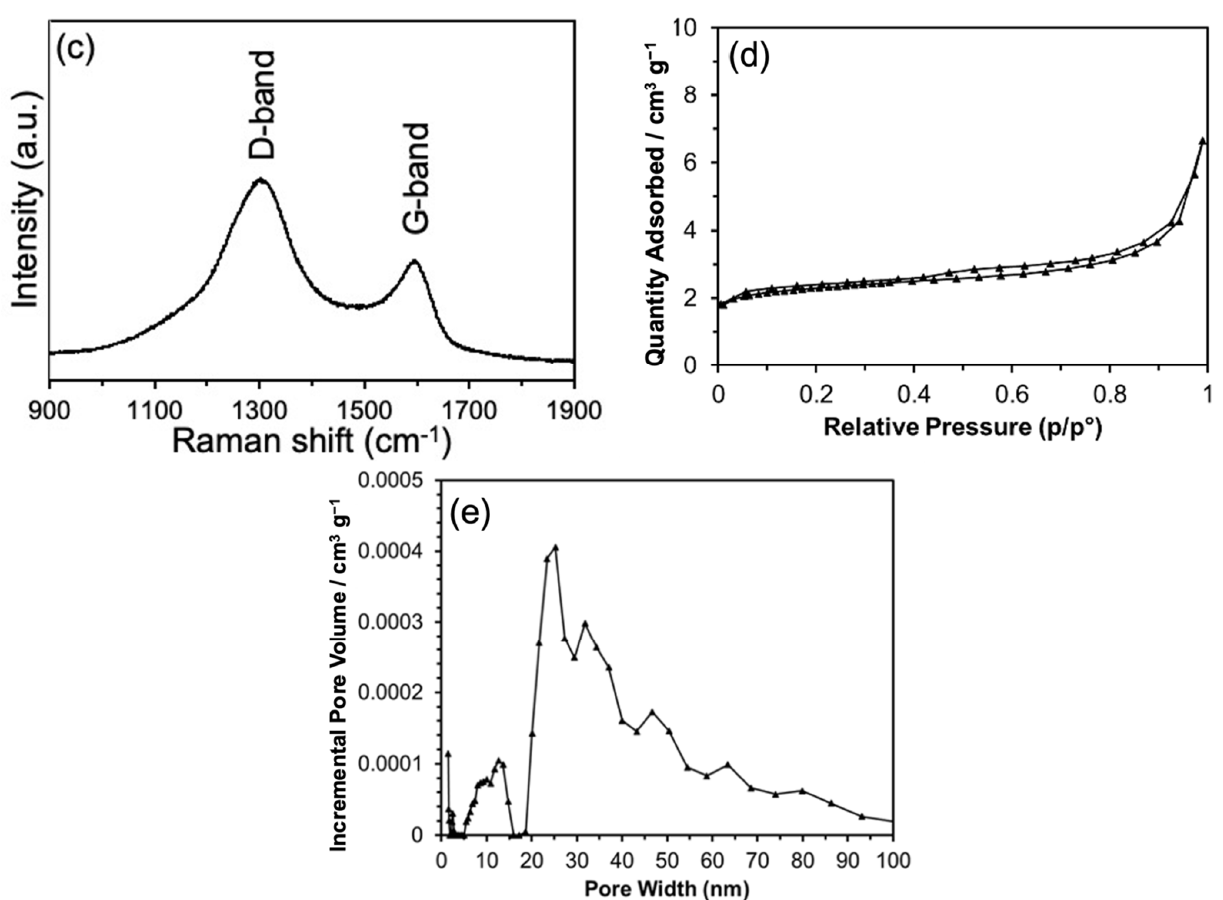
Figure 1. SEM micrograph ( a ), XRD pattern ( b ), Raman spectrum ( c ), N 2 adsorption–desorption isotherm ( d ) and pore size distribution ( e ) of the hard carbon used in this study.